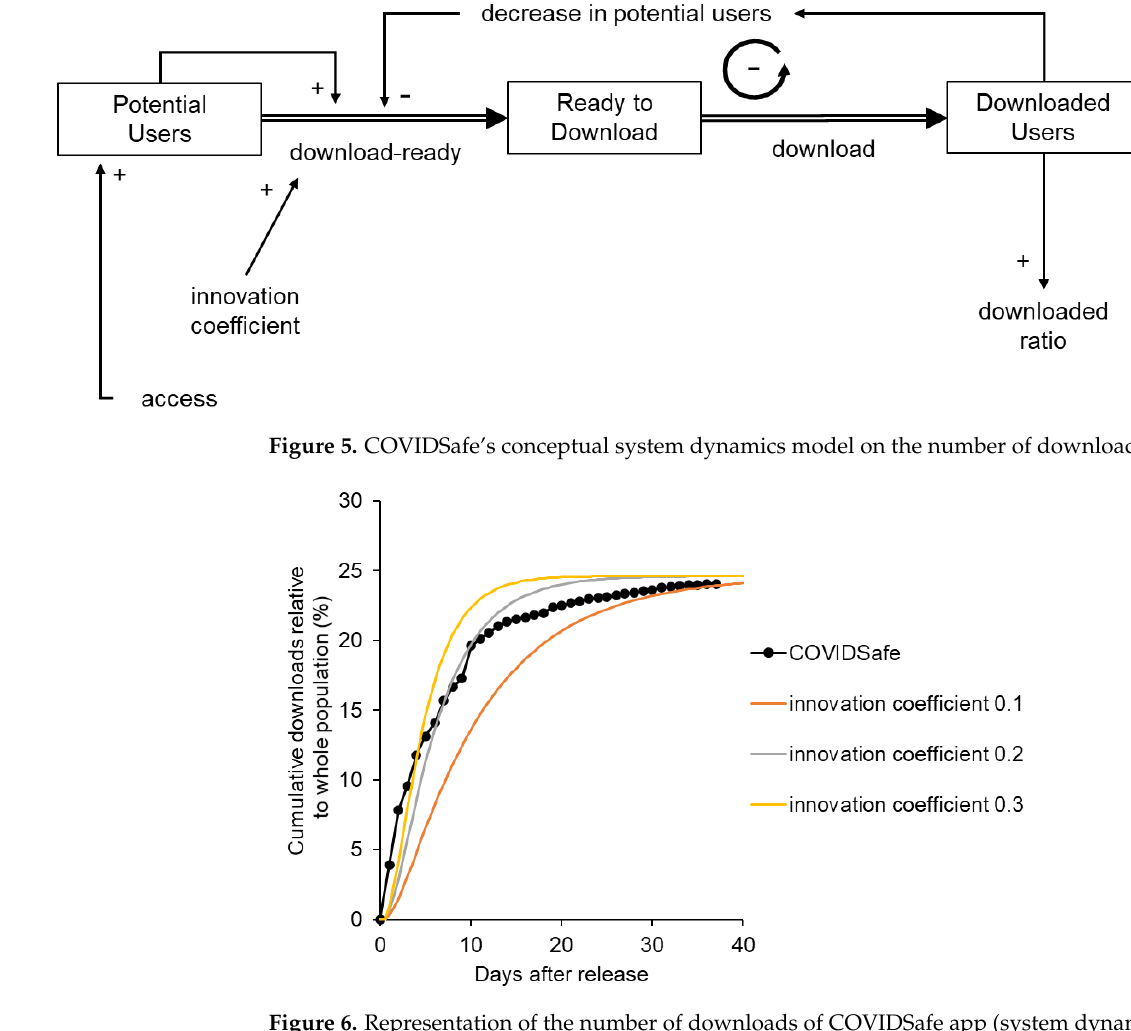
Figure 6. Representation of the number of downloads of COVIDSafe app (system dynamics